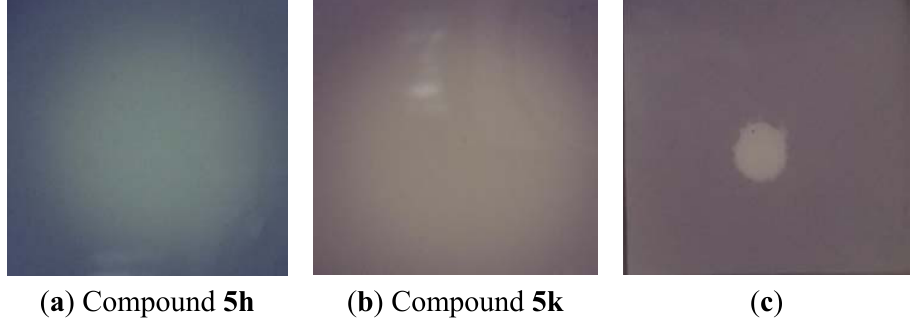
Figure 2. Antibacterial spot tests of compounds 5h , k